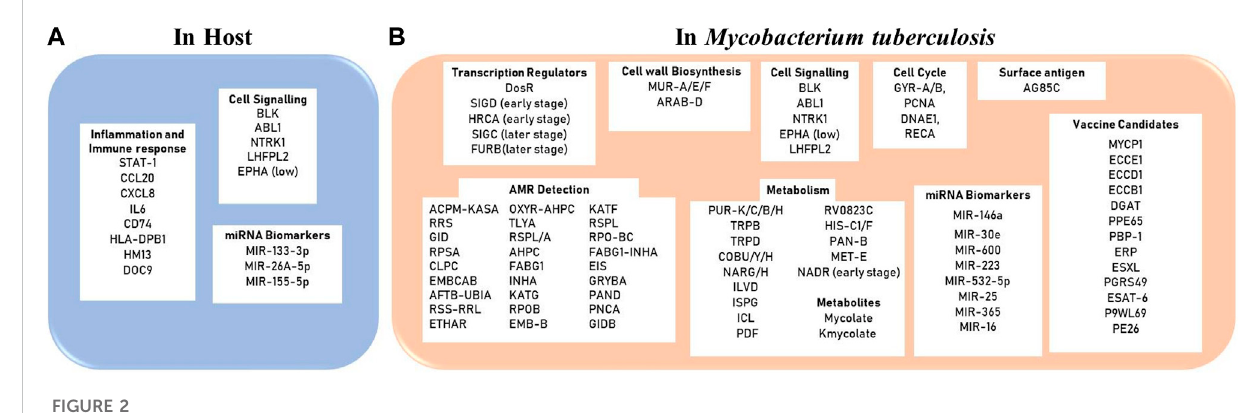
FIGURE 2 Diagnostic/Therapeutic Biomarkers reported using in silico approaches (A) in the host (humans) and (B) in the pathogen Mycobacterium